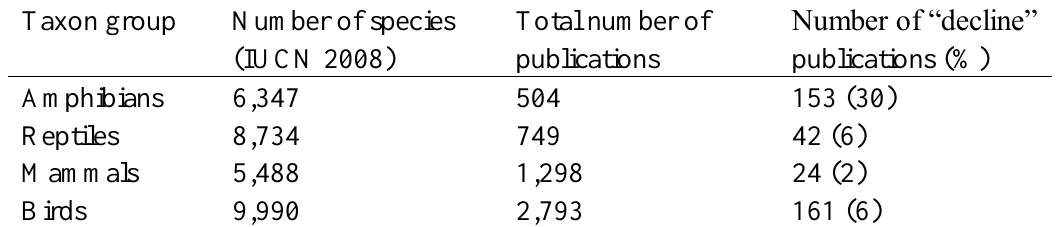
Table 1. Taxonomic comparisons (global). Numbers of publications are over the period 2005-2009 inclusive, in ―biodiversity and conservation‖ category